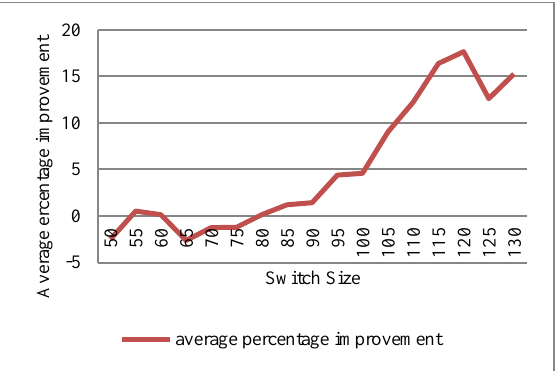
Figure 3. Average percentage of improvement of the ILS algorithm compared to SCIP.